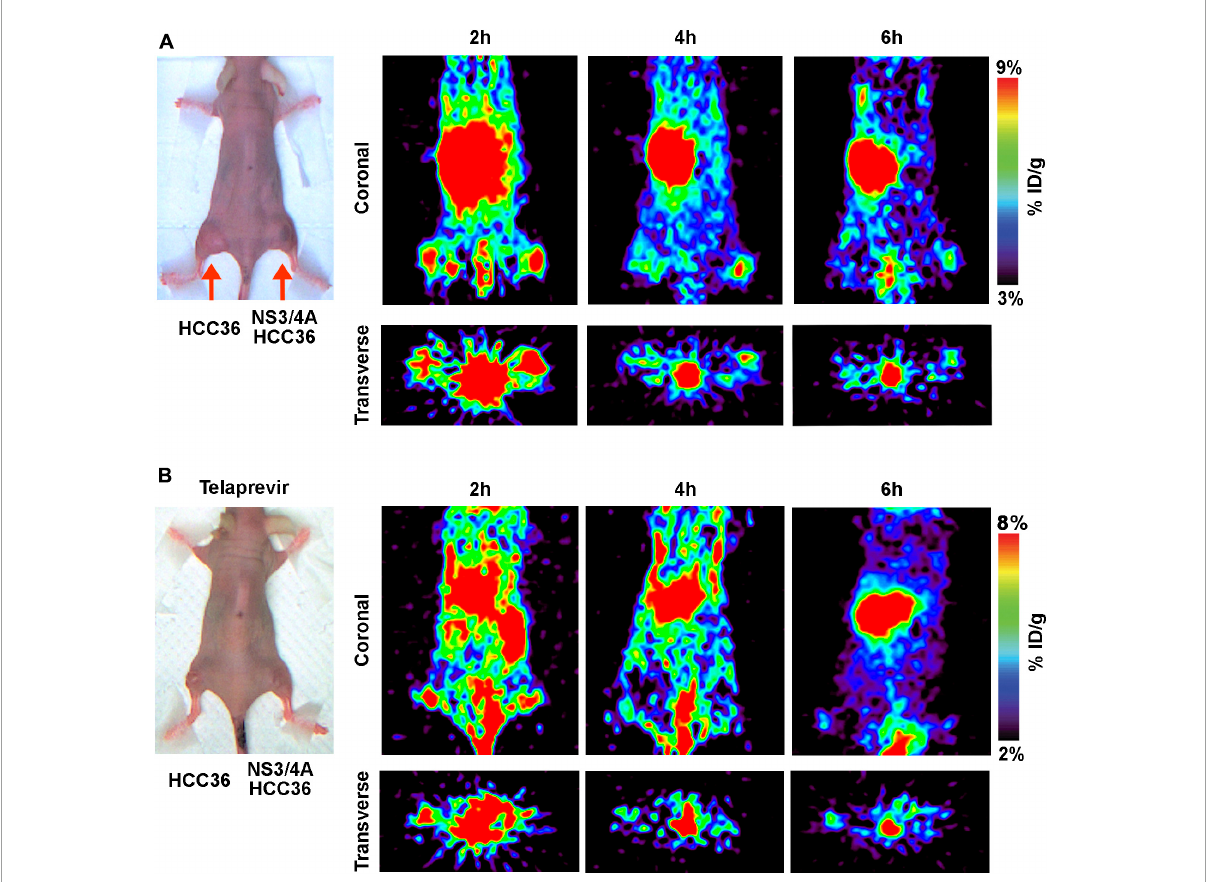
FIGURE5 Micro-PET imaging of NS3/4A activity in vivo . (A) Mice bearing established NS3/4A-HCC36 (right hind leg) and HCC36 (left hind leg) tumors were injected with 3,700 kBq of TAT- (cid:49) NS3/4A- 124 I-FITC. Coronal and transverse images were acquired at 2, 4, and 6 h after injection of the probe. (B) Mice bearing established NS3/4A-HCC36 (right hind leg) and HCC36 (left hind leg) tumors were intraperitoneally injected with telaprevir (20 mg/kg/day for 3 days) before intravenous injection of TAT- (cid:49) NS3/4A- 124 I-FITC (3,700 kBq). Coronal images of tumor sections were acquired at 2, 4, and 6 h after injection of the